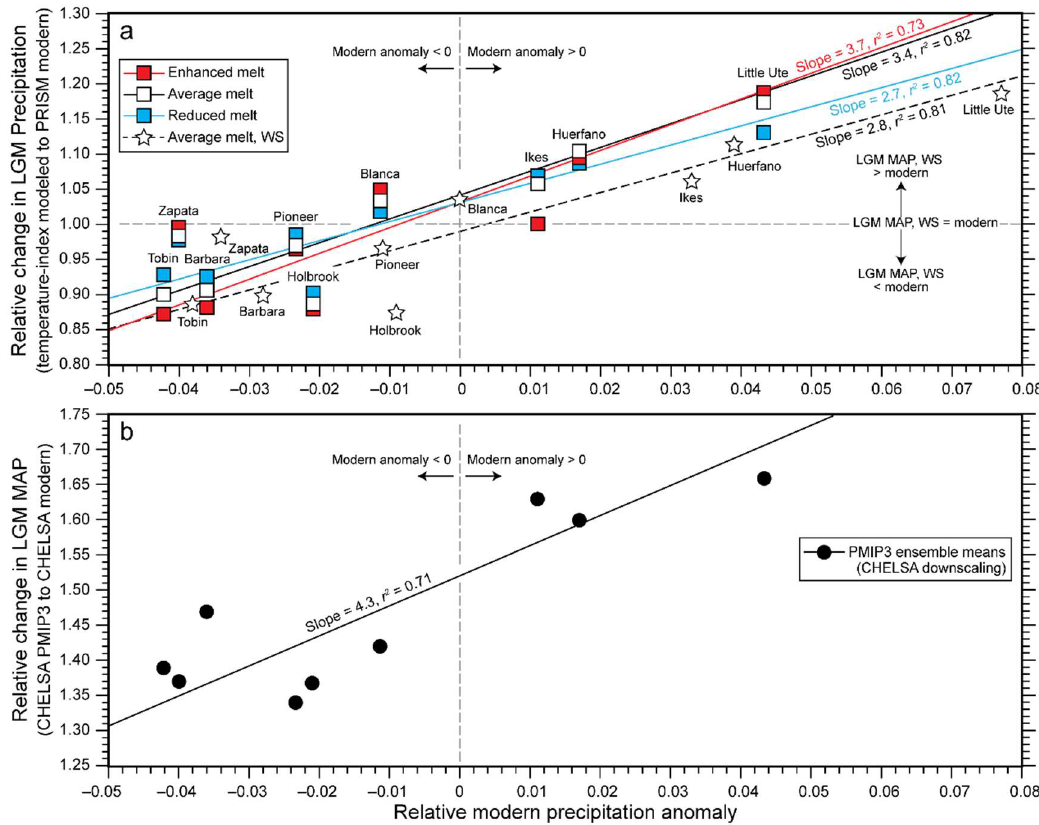
Figure 11. ( a ) Correlations (via reduced major axis) between the relative changes in LGM mean annual (MAP) or winter and spring (WS) precipitation for different melt scenarios and relative modern precipitation anomalies (the anomaly expressed as a fraction of MAP expected based on elevation using PRISM climatologies) in individual glaciated valleys. The relative precipitation anomaly is used rather than the anomaly itself because identical anomalies would represent different magnitudes of change owing to differences in total precipitation. For all regressions, p < 0.005. ( b ) As in ( a ), but using the relative changes in MAP yielded by the difference between LGM ensemble means of the CHELSA downscaled PMIP3 models and CHELSA modern climatology ( p < 0.01).